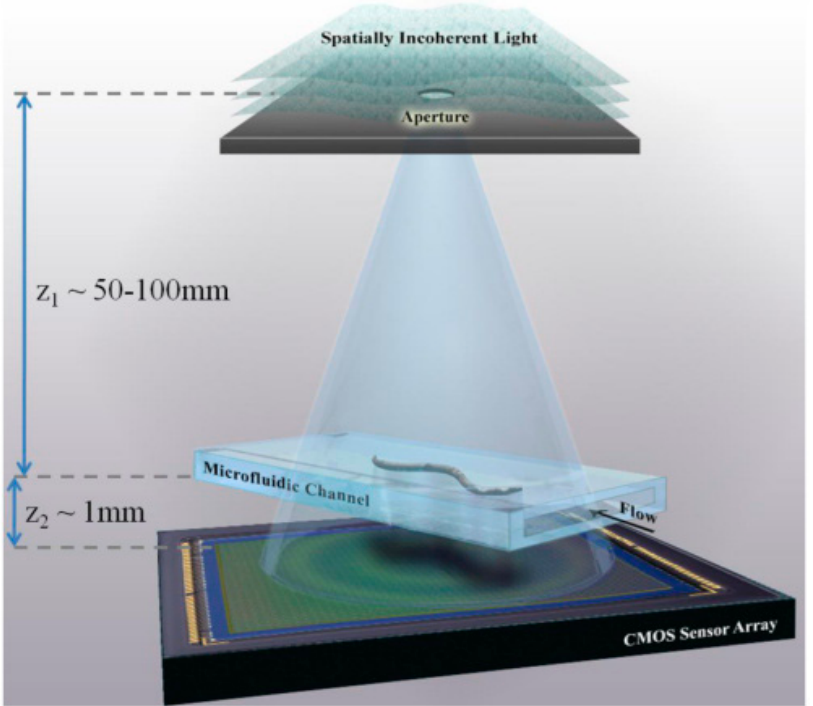
Figure 4. Experimental setup of conducting holographic optofluidic microscopy images of microfluidic devices. Reproduced from [43] under Creative Commons Attribution 4.0 License.